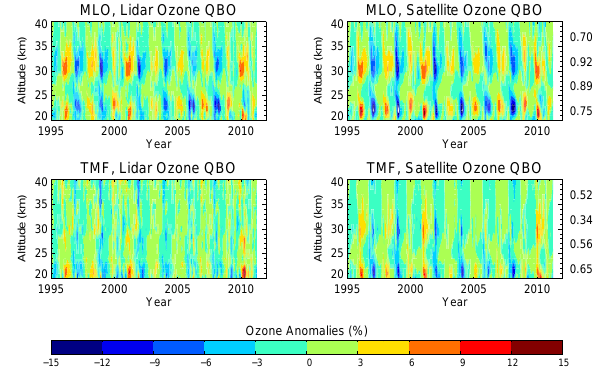
Fig. 7. 2-D contours of the ozone QBO perturbation reconstructed from the regression analysis applied to lidar and satellite data. Cor- relation coefficients calculated between lidar and satellite responses are indicated on the right-hand